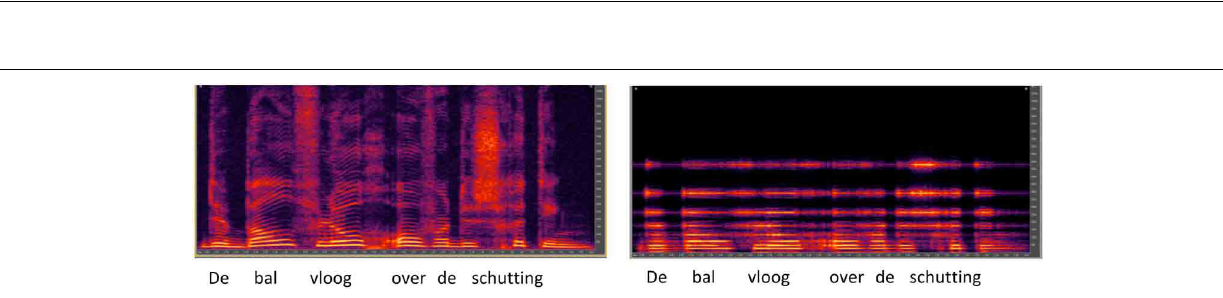
Frontiers in Neuroscience | Auditory Cognitive